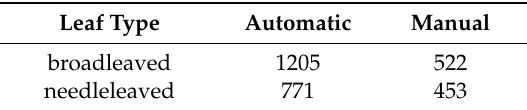
Table 1. Number of training polygons for respective leaf-type derived through automatic and manual selection from the OpenStreetMap database in